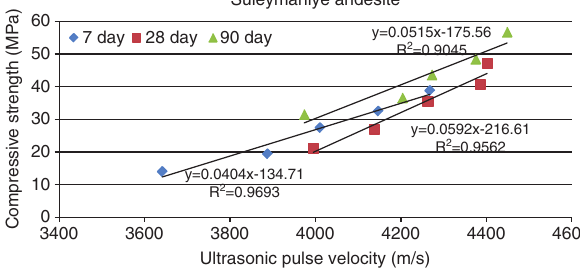
Figure 6 Relationship between ultrasonic pulse velocity and com- pressive strength of samples for Suleymaniye andesites.